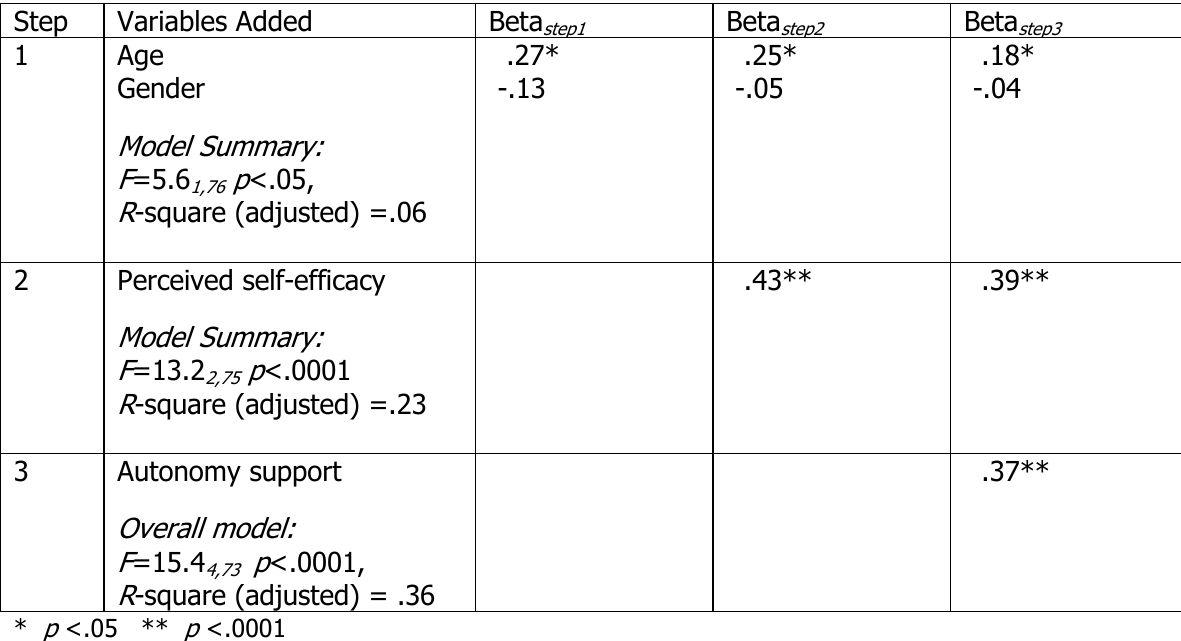
Hierarchical regression predicting participatory group